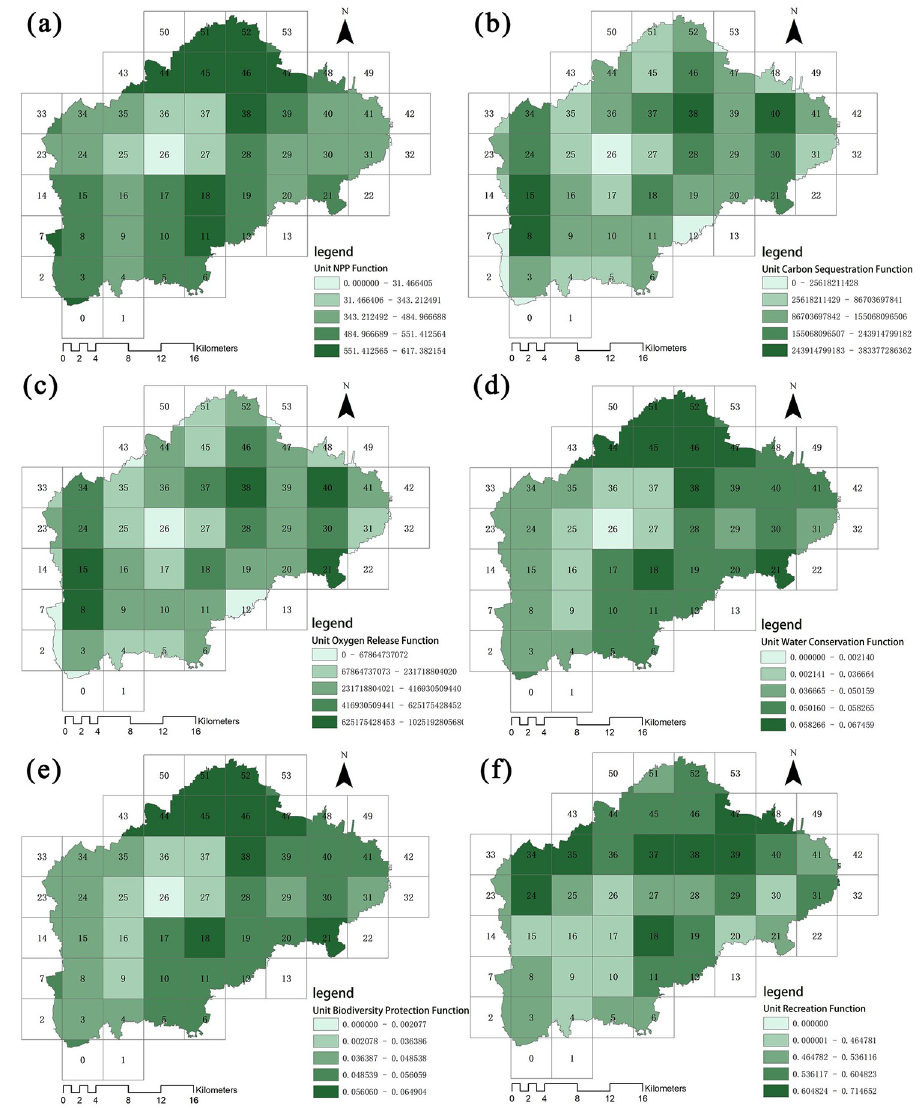
Fig 6. Forest ecosystem service functions across study units. Maps show the distributions of (a) NPP, (b) carbon sequestration, (c) oxygen release, (d) water conservation functions, (e) biodiversity conservation and (f) recreation.